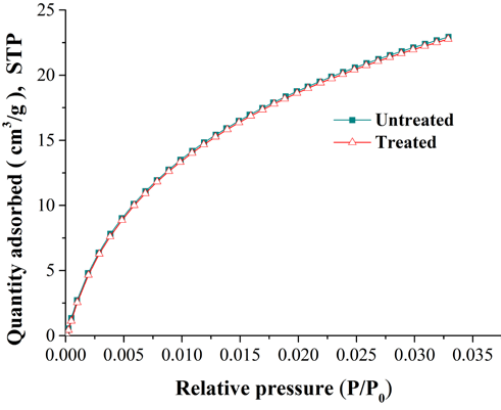
Figure 2. The adsorption isotherms for carbon dioxide at 273 K.